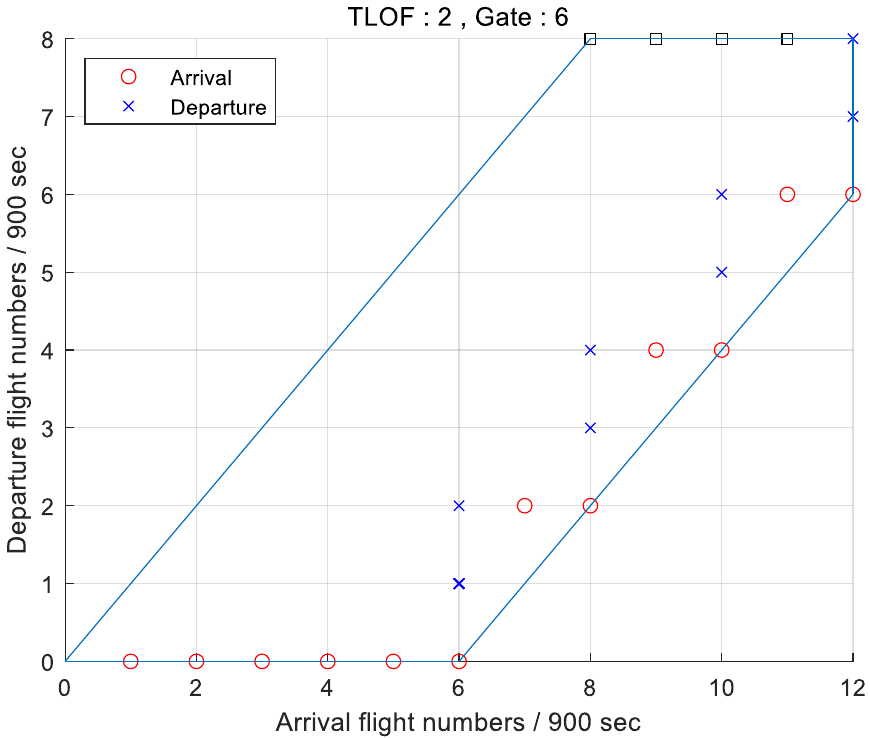
Figure 27. The linear topology capacity of the current Gimpo Airport parking lot that complies with the FAA’s new regulations.